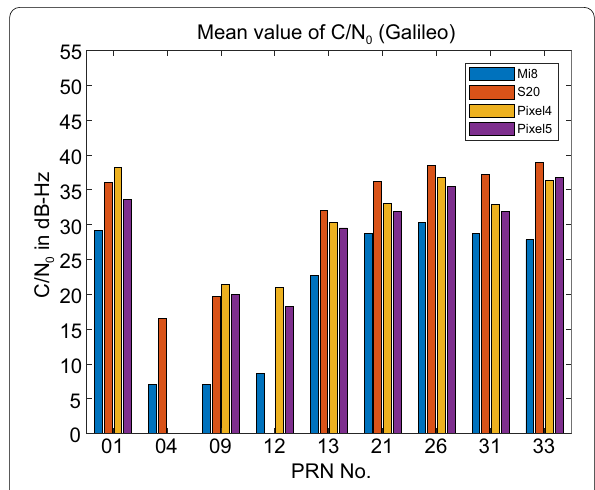
Fig. 8 Mean value of C/N 0 for all Galileo